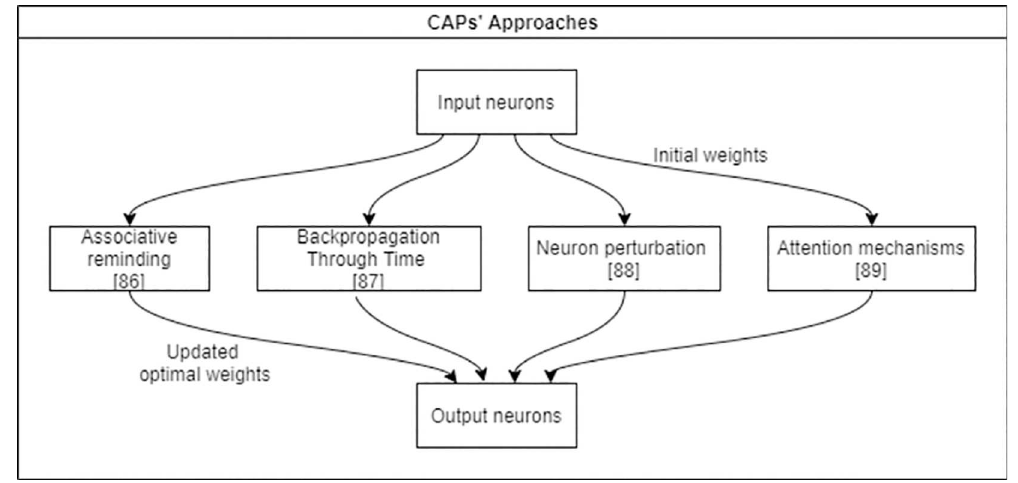
Fig 6. Recent approaches for DNNs credit